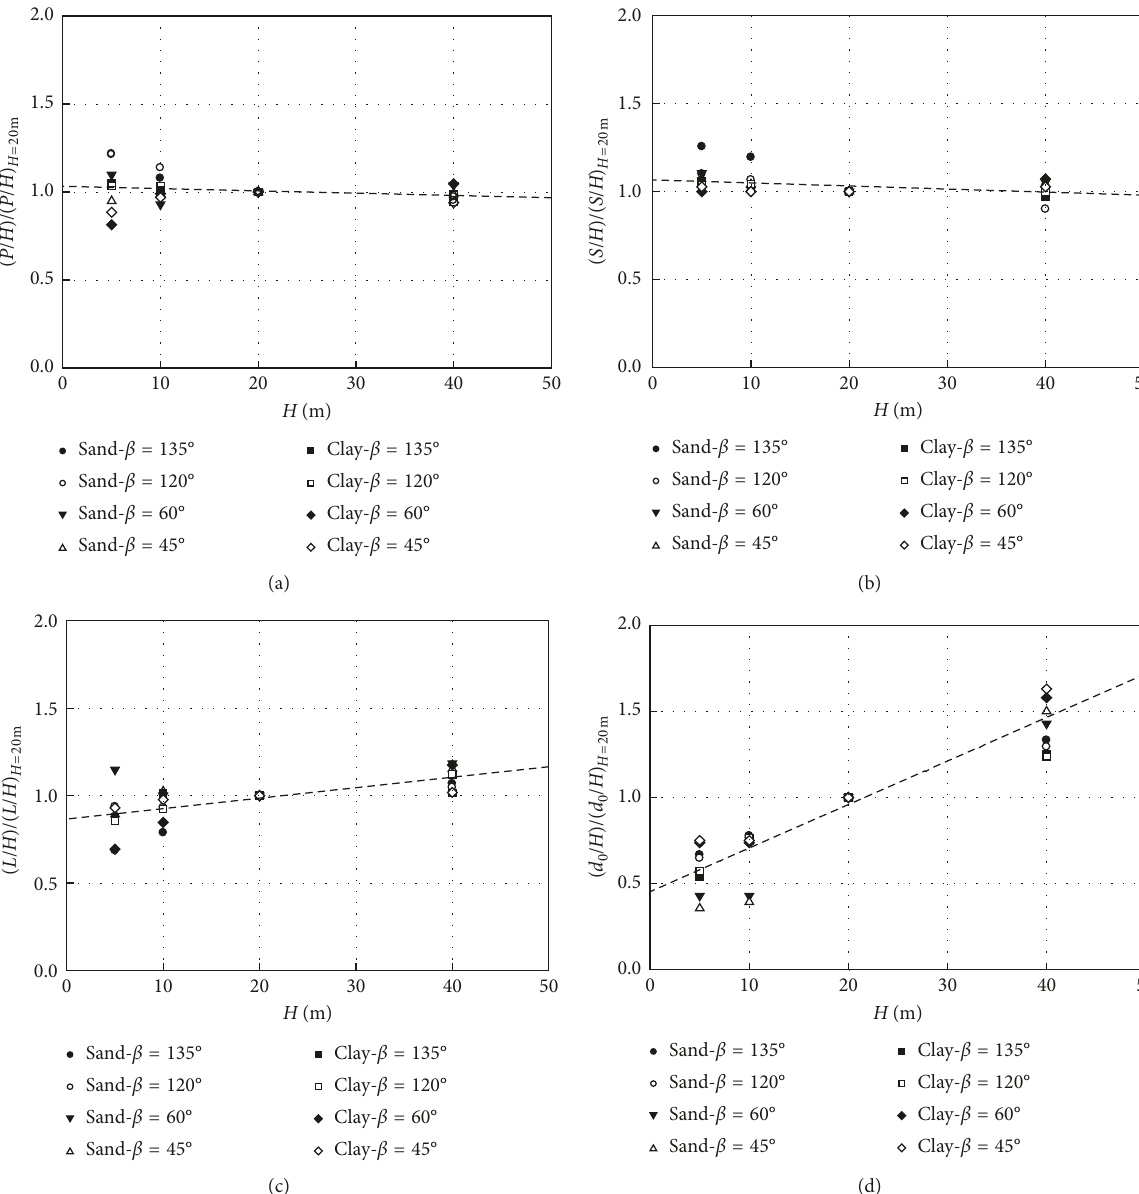
Figure 18: The relationship curves between H and various parameters: (a) P / H , (b) S / H , (c) L / H , and (d) d